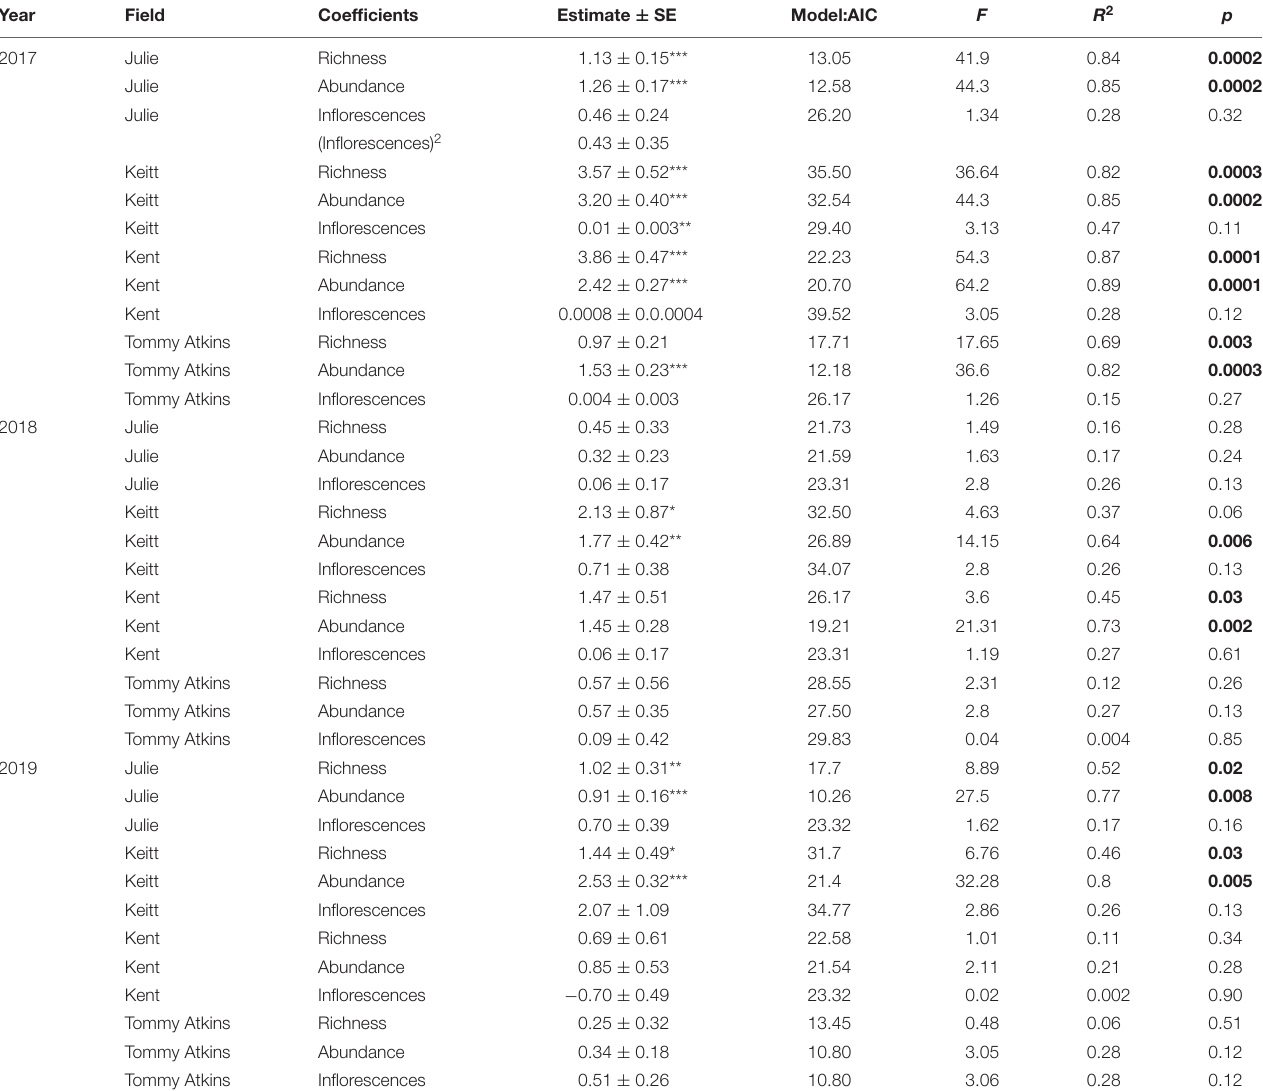
TABLE 4 | Results for simple regression coefficients from general linear model (GLM) analyses evaluating the variation in reproductive success (plant yield) as a function of insect species richness, insect abundance and the number of inflorescences/trees in four field of M. indica in 3 separate years.